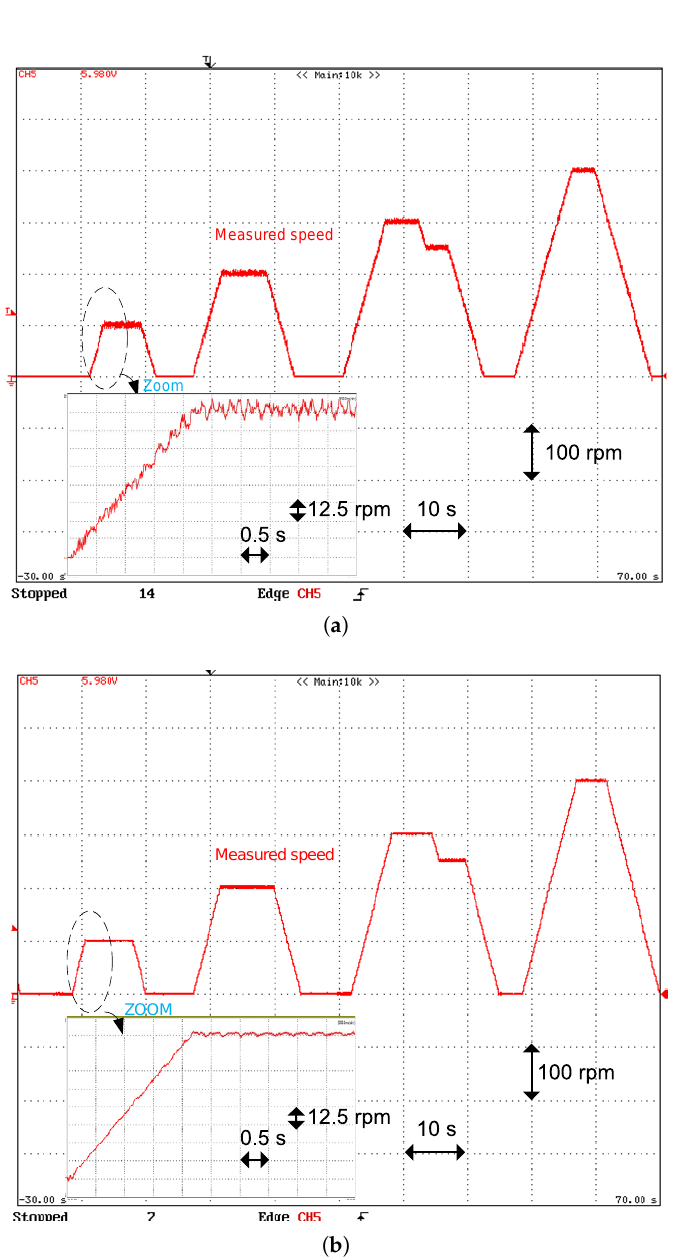
Figure 13. Experimental plots: Bus speed during the proposed cycle: ( a ) classical DTC method based on a PI control, ( b ) the proposed